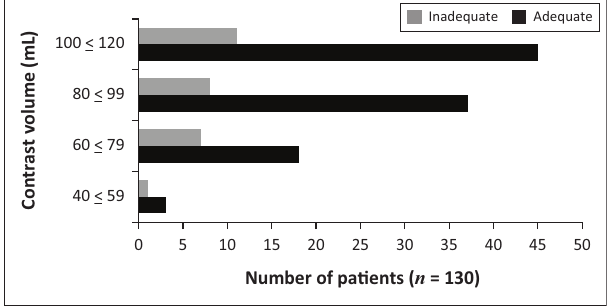
FIGURE 2: Frequency of adequate and inadequate contrast-enhanced CTPAs in the prospective group of patients for different contrast volumes.